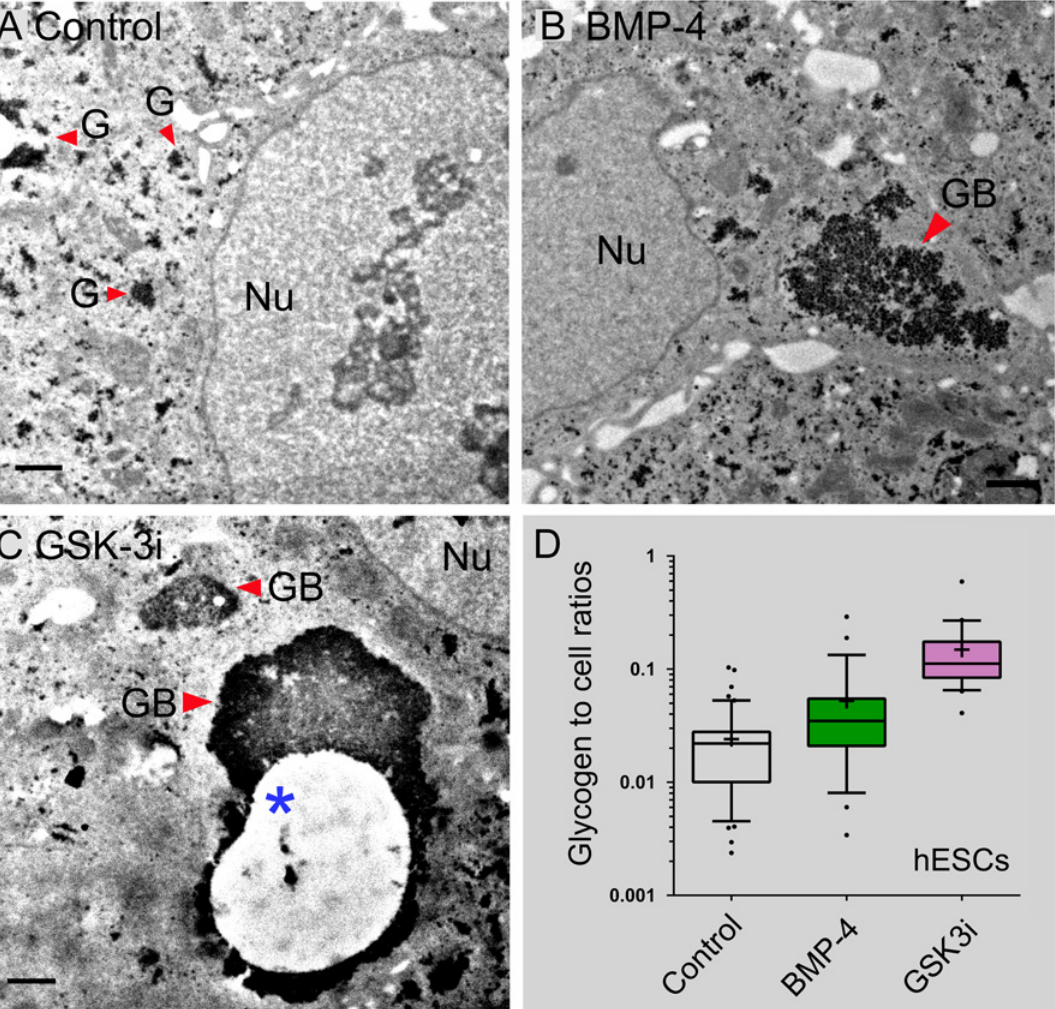
Fig 3. TEM analysis of glycogen synthesis and the formation of glycogen bodies mediated by BMP-4 and GSK-3 inhibition in hESCs. ( A ) Glycogen body formation in untreated H1 cells (control). ( B ) Glycogen body formation in BMP-4 treated H1 cells. ( C ) Glycogen body formation in GSK3i (CHIR99021)- treated H1cells. The asterisk sign indicates a glycogen defect region in the glycogen body, which likely resulted from dissociation of glycogen aggregates when the specimens were floating in solution during sample preparation. Additional TEM micrographs are available in Supporting Information S1 Fig and S2 Fig. ( D ) Box-and-Whisker plots of glycogen to cell ratios (with 10 – 90% percentile) in hESC control (n = 49 cells), BMP-4 treated cells (n = 29), and GSK3i treated cells (n = 22). The statistics included both H1 and H9 cells to increase statistical power. All hESC (i.e., H1 and H9) cells were grown as a non-colony type monolayer (mc) on 2.5% BD Matrigel in meTeSR1 medium and then treated with 100 ng/mL of BMP-4 and 3 μ M GSK3i for 48 hours. The red-colored arrowheads indicate the formation of glycogen bodies (GB) in the cytoplasm of the cell. The plus signs (+) in the plots indicate the location of mean